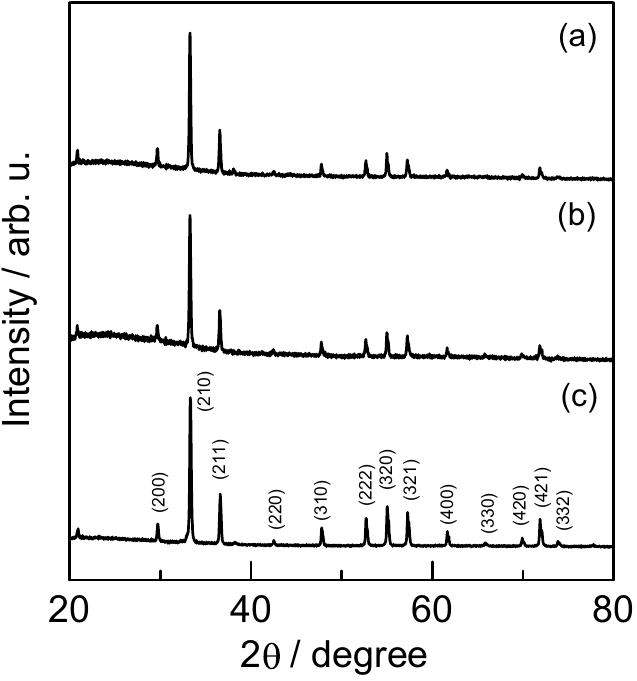
Figure 1. XRD patterns for samples synthesized at dropping rates of ( a ) 0.020 cm 3 s −1 and ( b ) 0.33 cm 3 s −1 . For comparison, a diffraction pattern measured for ( c ) commercial silver phosphate is also